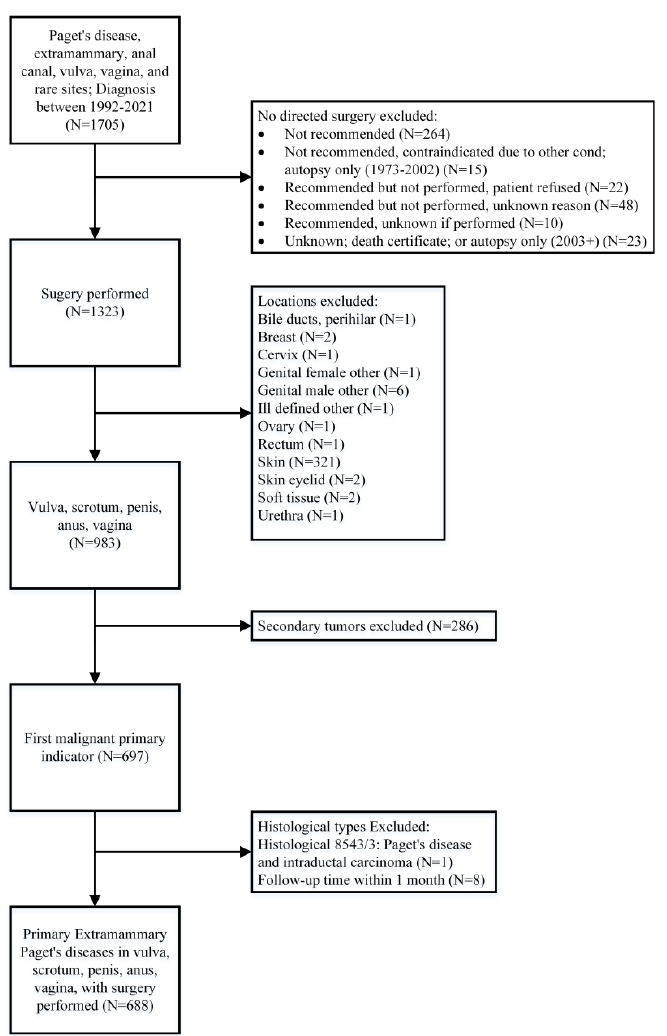
Figure 1. The screening process for the Surveillance, Epidemiology and End Results (SEER) program data.